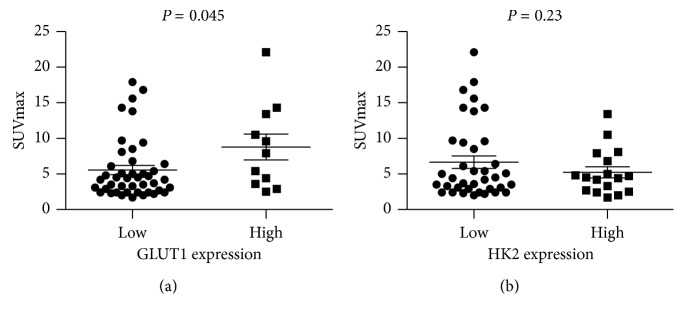
The relationship between SUVmax and the expression of GLUT1 and HK2 in primary ccRCC tumors. (a) The relationship between SUVmax and GLUT1 expression in primary ccRCC tumors. The SUVmax of ccRCC in the high GLUT1 expression group (mean, 8.78 ± 6.04) was significantly higher than that in the low GLUT1 expression group (mean, 5.55 ± 4.23; P=0.045). (b) The relationship between SUVmax and HK2 expression in primary ccRCC tumors. There was no significant difference in SUVmax according to HK2 expression groups (P=0.23).